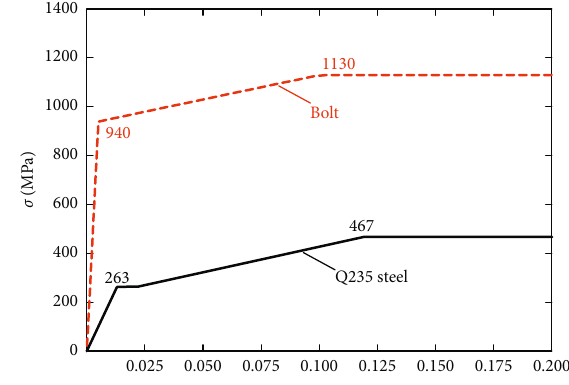
Figure 5: Stress-strain curve of Q235 steel and the high-strength